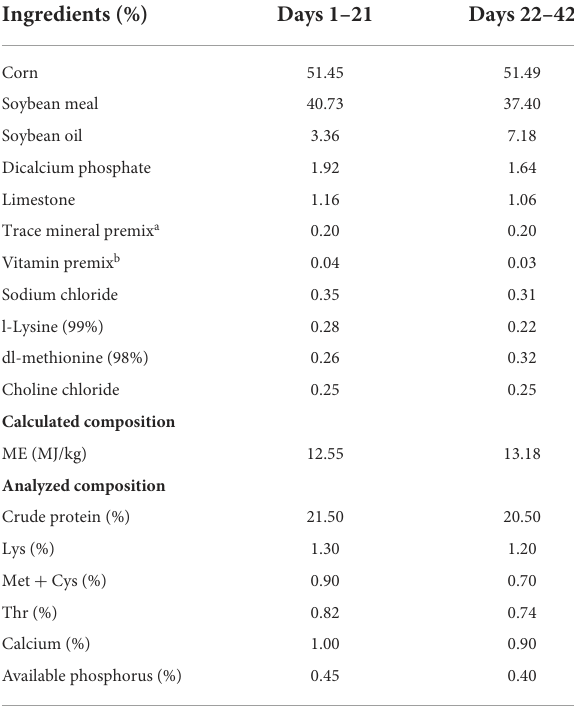
TABLE 1 Composition of experimental diets (as-fed